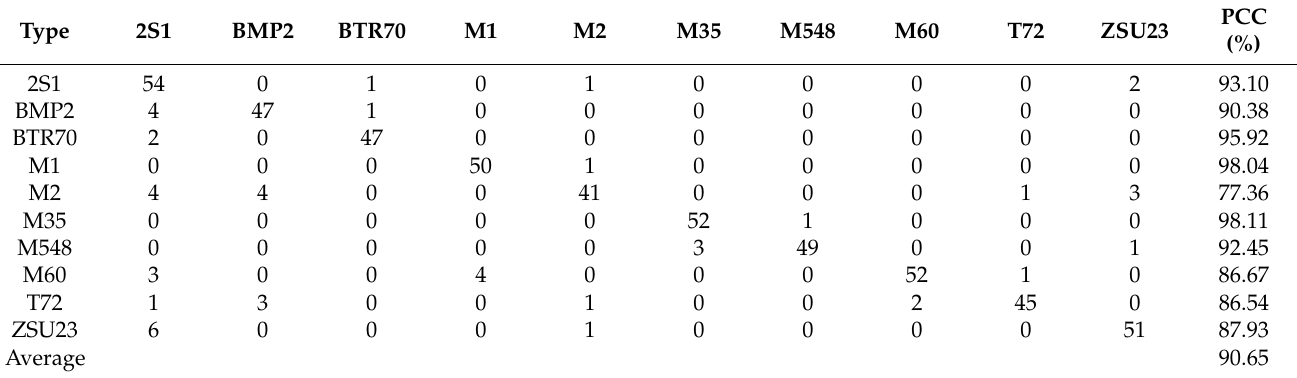
Table 2. Recognition results obtained using the proposed method within 10 target classification tests (test image: real 17 ◦ , template image: synthetic 16 ◦ /17 ◦ ).